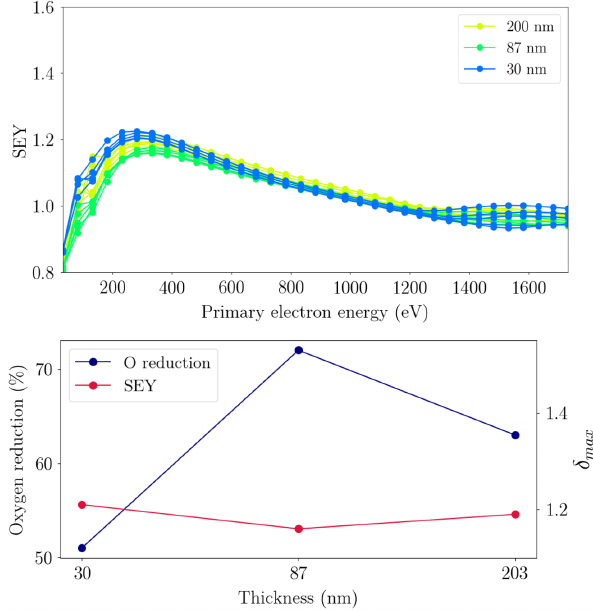
FIG. 13. SEY as a function of the photoelectrons energy (top) and oxygen reduction and maximum SEY as a function of the coating thickness (bottom) for the thin films after the fourth activation cycle of 24 hours up to a temperature of 250